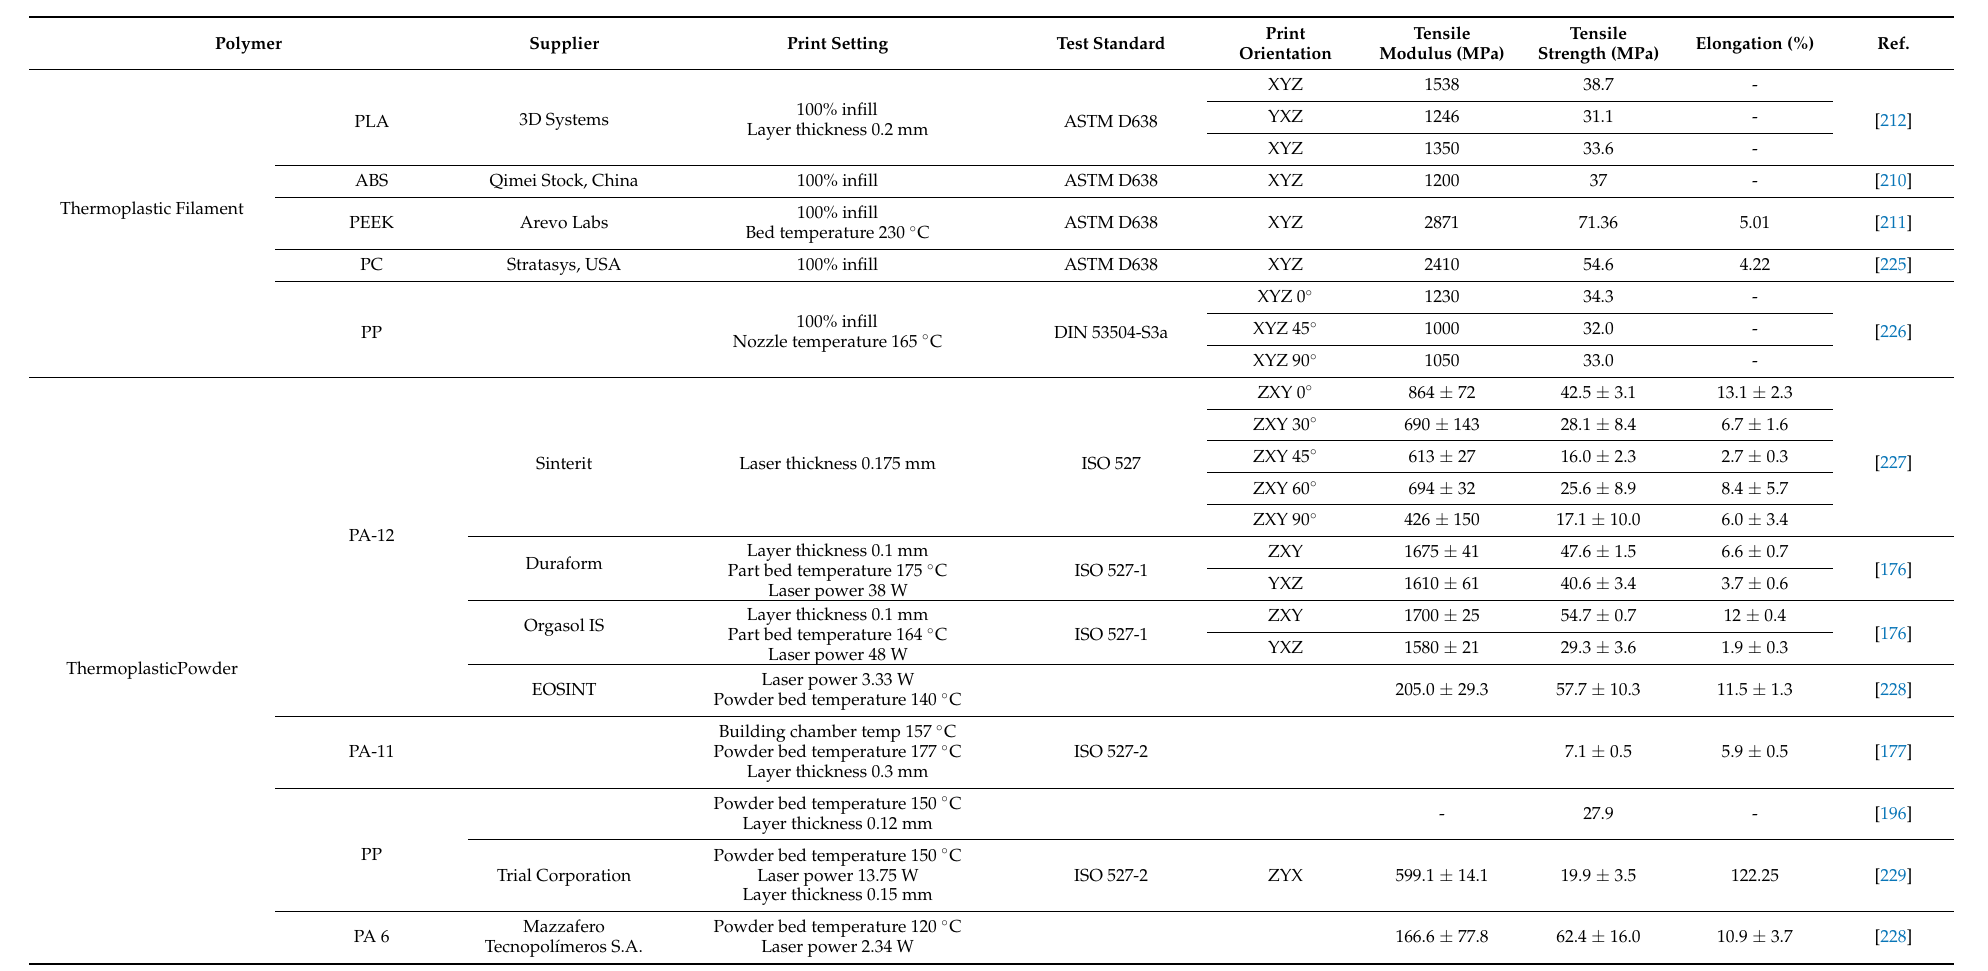
Table 5. A summary of the tensile properties of a few common print materials for all three, FDM, SLS, and SLA, printing techniques. Information such as print setting, test standard method, print orientation, tensile modulus, tensile strength, and elongation at break are